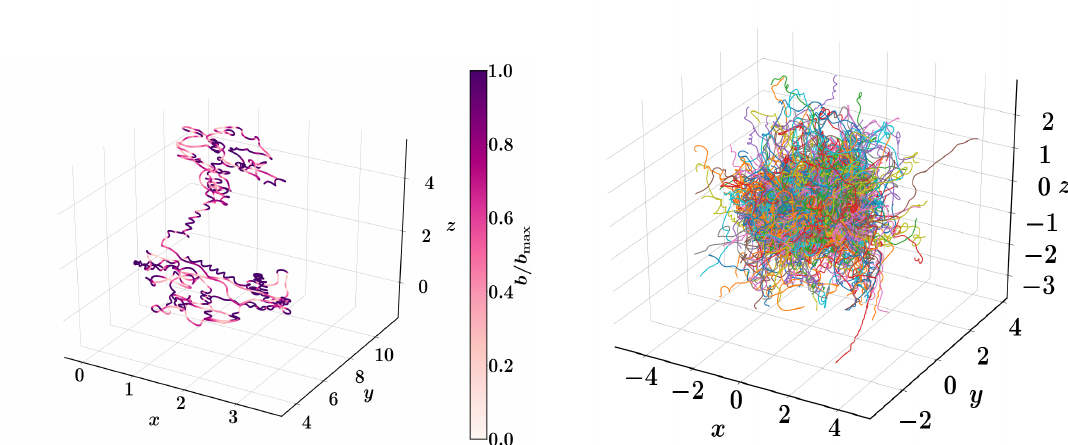
Figure 5. Left panel: Trajectory of a single particle with r L / l 0 = 0.02 propagating in the field shown in Figure 4; the colour shows the magnetic field strength normalized to its maximum value along the trajectory. The particle performs gyrations in strong field regions (following magnetic field lines), but is also scattered in relatively weak field regions. Right panel: Trajectories for an ensemble of particles with r L / l 0 = 0.02 and the same initial spatial location within the numerical domain, but random velocity directions (different coloured lines are for particles with different initial velocity directions). The particle distribution over large scales in time and length becomes isotropic due to numerous scattering events, which leads to cosmic ray